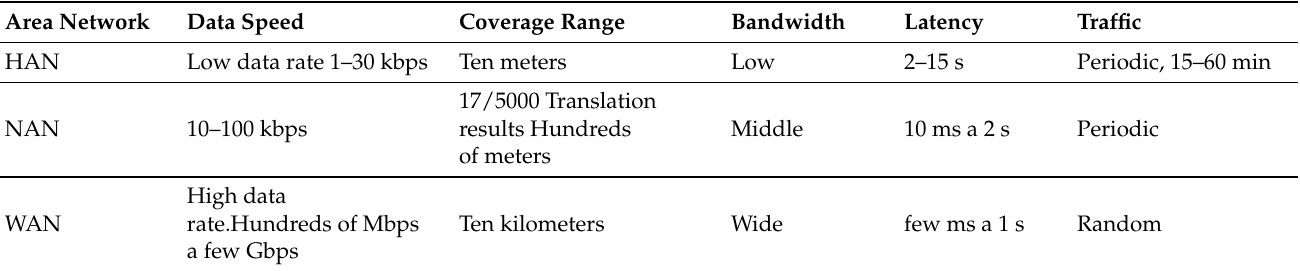
Table 1. Area network